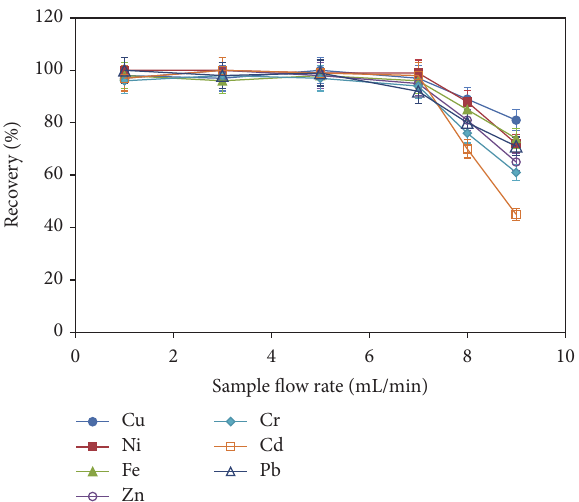
Table 2: Total sorption capacity of the metal ions on the Amberlite